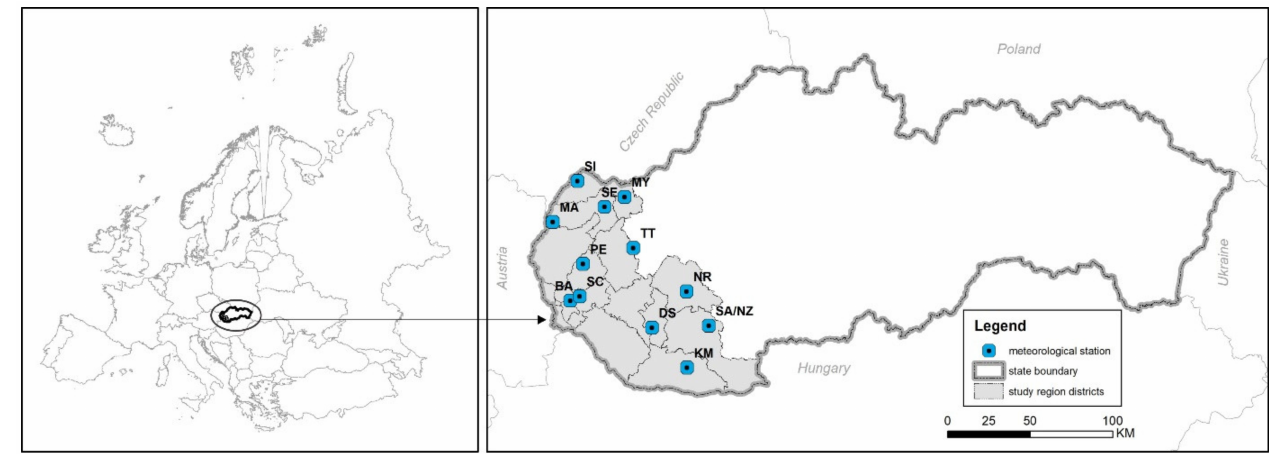
Figure 1. Study area and locations of